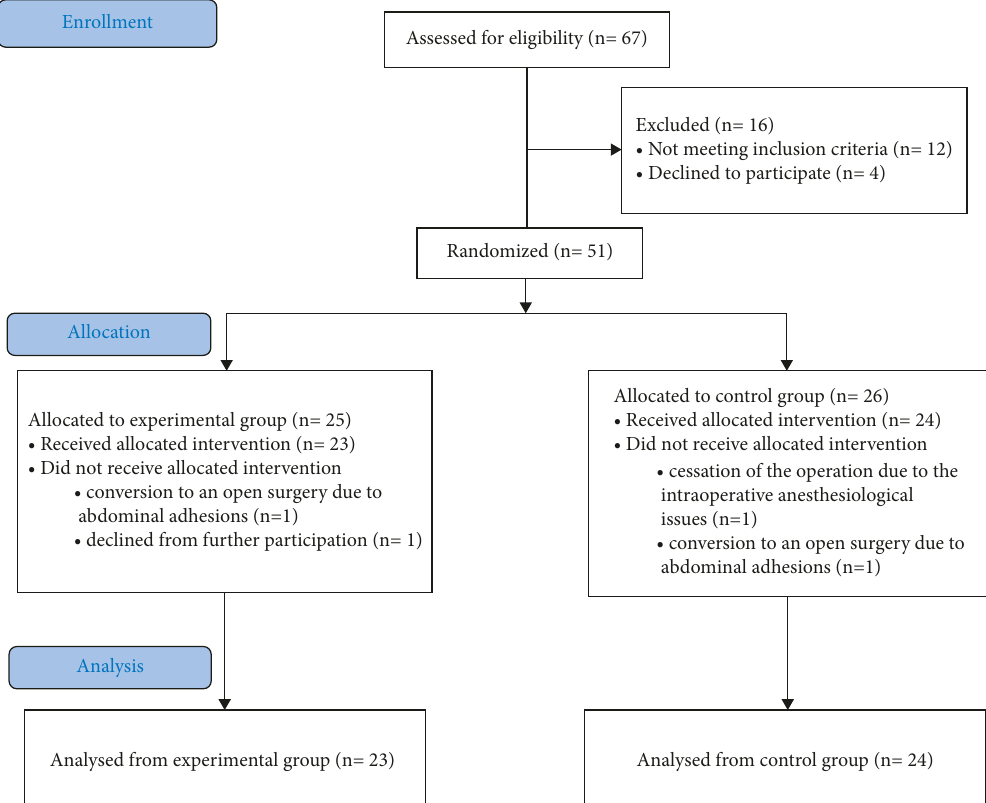
Figure 1: Flow of participants in the “mixed reality technology for LPN”